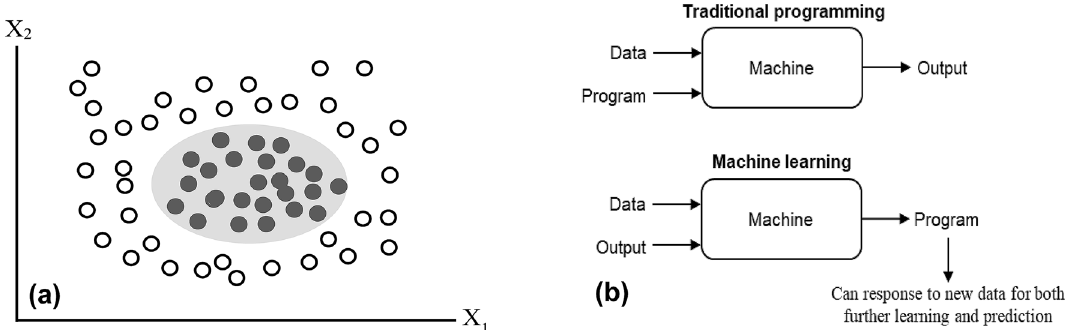
Figure 2. ( a ) An illustration showing the superior performance of machine learning models compared with the traditional statistical models using an abstract dataset with two attributes (X 1 and X 2 ). The data points within this abstract dataset consist of two classes: one represented with a transparent circle and the second class illustrated with a black-filled circle. These data points are non-linear but separable. Traditional statistical models (e.g., ordinary least square regression) will not accurately separate these data points. However, any machine learning model can easily separate them without making errors; and ( b ) Traditional programming versus machine learning.